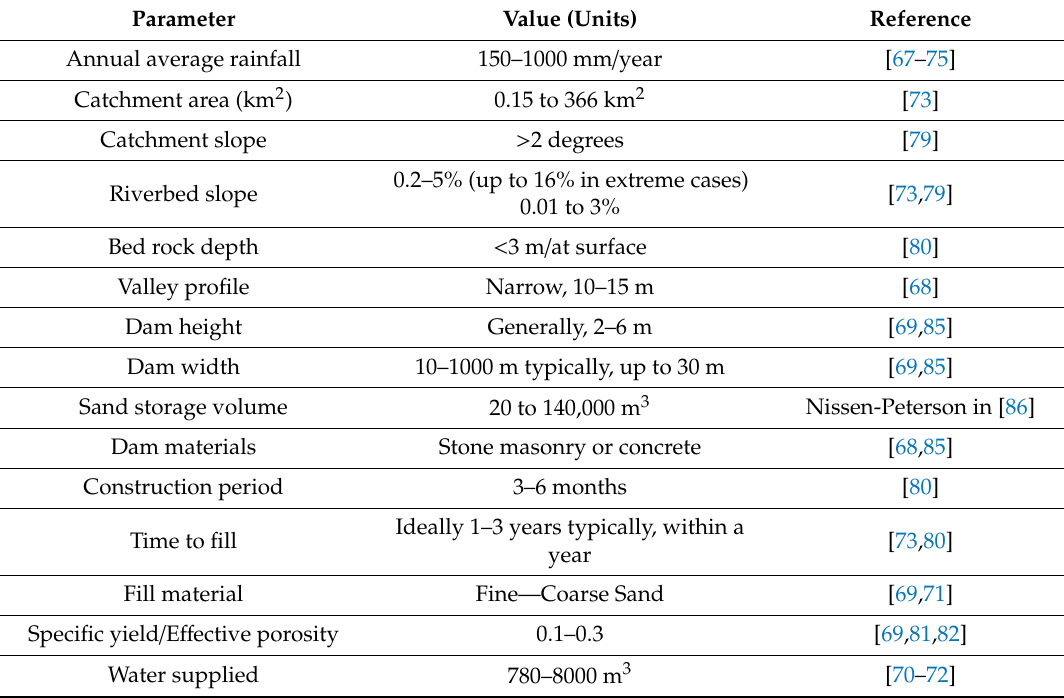
Table 3. Typical sand storage dam